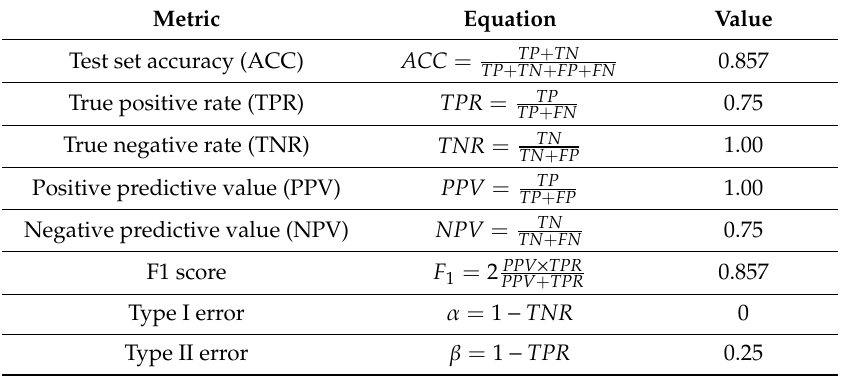
Table 7. Performance metrics of support vector machine